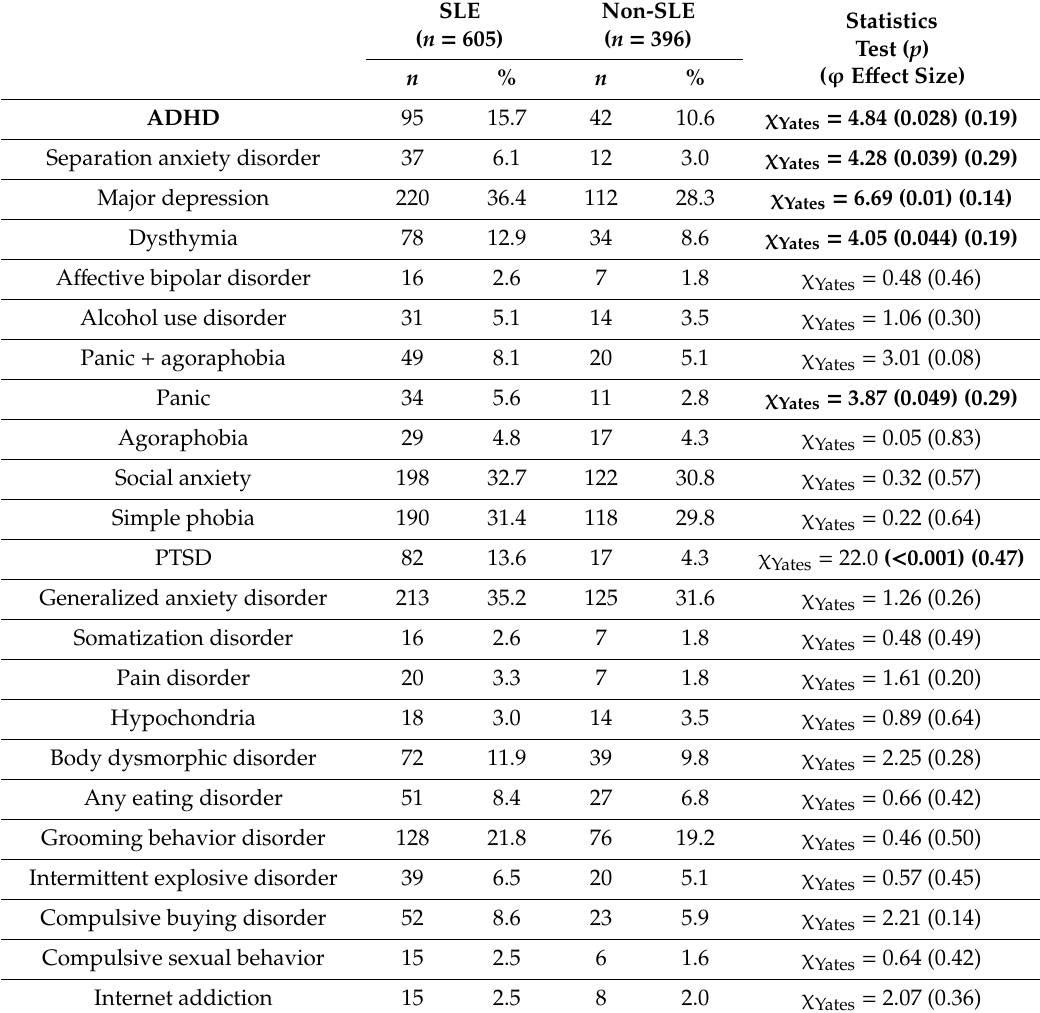
Table 4. Comparison of psychiatric comorbidities between SLE and non-SLE